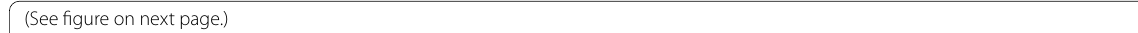
category (Fig. 6B), membrane region and raft, cell pro- jection membrane, microvillus, and brush border mem- brane in the cellular component group (Fig. 6C).